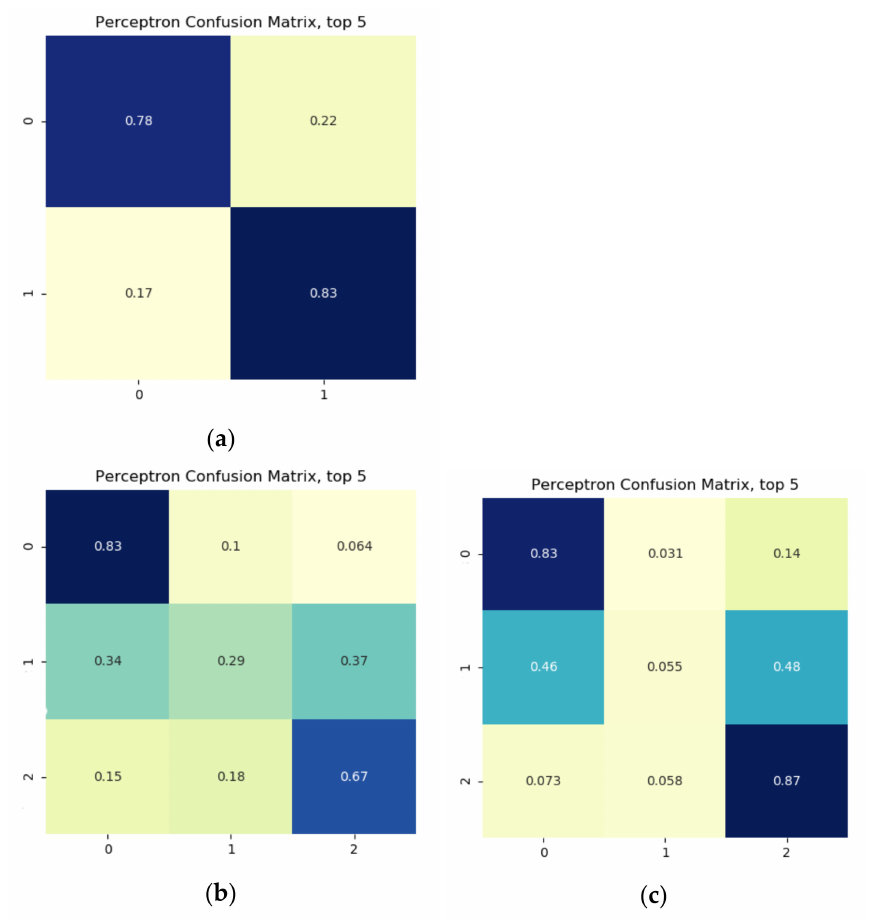
Figure 13. Confusion matrices for pod maturity classification using top five discriminating features of ( a ) [Set 1], immature + mid-mature (class 0) vs. mature + over-mature (class 1), ( b ) [Set 2], immature + mid-mature (class 0) vs. mature (class 1) vs. over-mature (class 2), and ( c ) [Set 3], immature (class 0) vs. mid-mature (class 1) vs. mature + over-mature (class 2). Note that the distinction between mid-mature from immature and ripe is challenging. The same is true for distinction between mature and